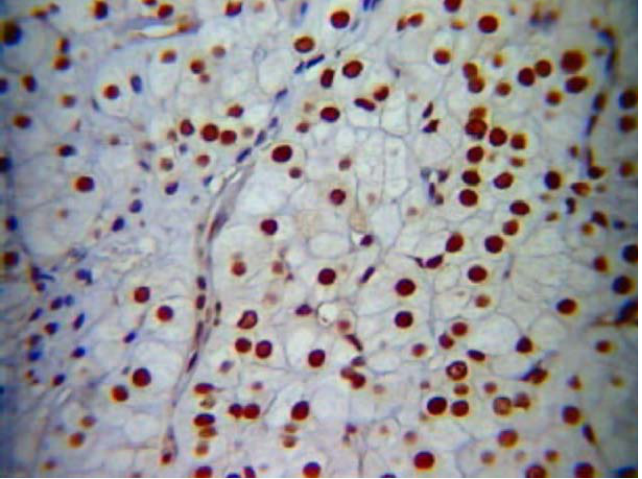
Fig. 1 PCNA in raw micrograph of a parathyroid